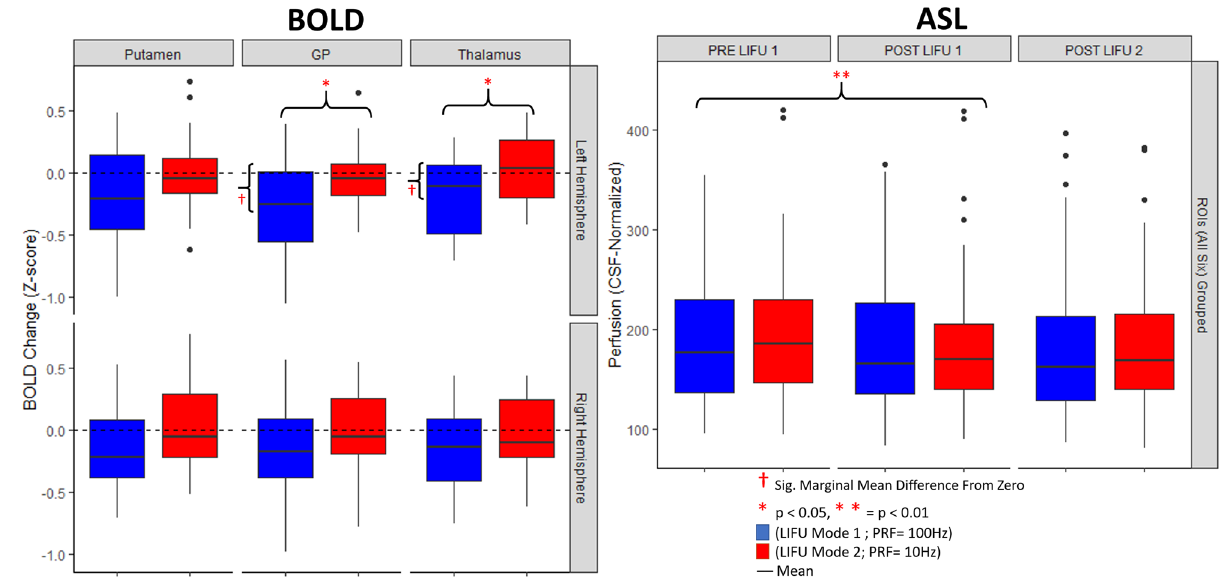
Figure 3. ROI analysis results. Left: online changes in BOLD signal during LIFU sonication blocks compared to inter-sonication blocks (i.e., baseline) for the target Left GP ROI, in the proximal Left putamen and Left thalamus ROIs, and in the right Putamen, GP, and Thalamus during Mode 1 (blue) and Mode 2 (red) sonication, compared to baseline (Red crosses indicate a significant difference from baseline for an individual condition while red Asterisks indicate significant difference across conditions). Right: offline changes in ROI perfusion (all six ROIs are grouped) before LIFU, after run 1, and after run 2 for each sonication mode (Red Asterisks indicate significant difference across conditions). Whiskers represent 1.5 times the interquartile range above the 75th percentile and below the 25th